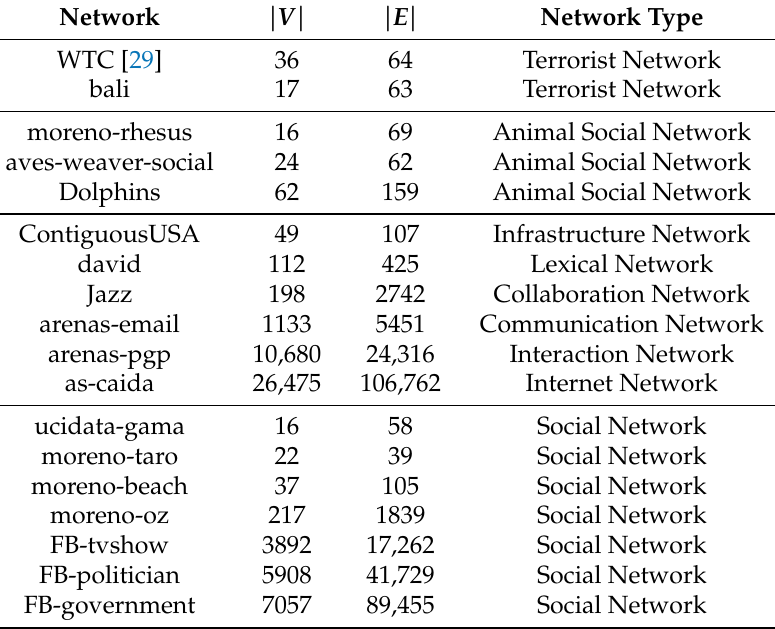
Table 3. Real-life